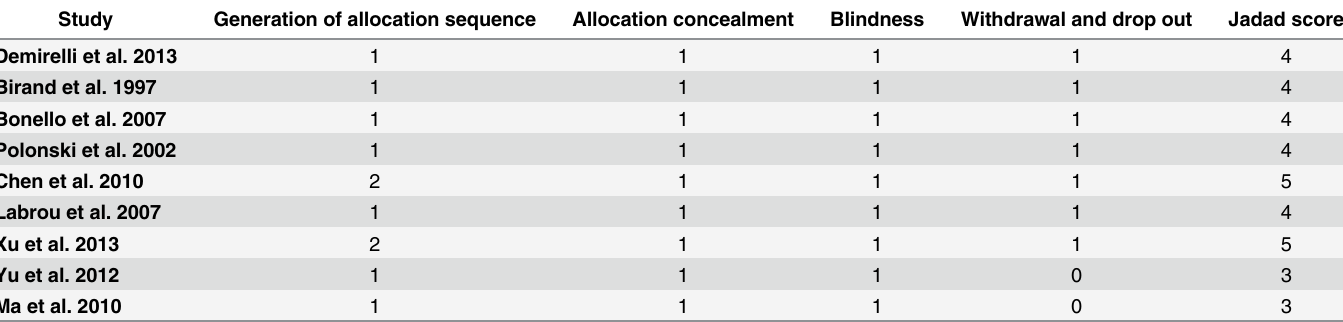
Table 3. Quality Assessment of Included